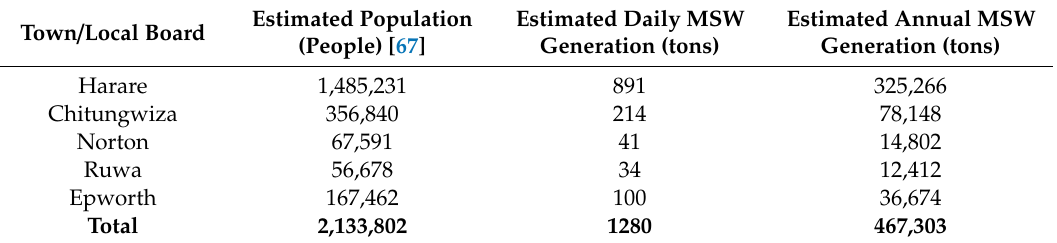
Table 2. Estimates of daily and annual municipal solid waste (MSW) generation.